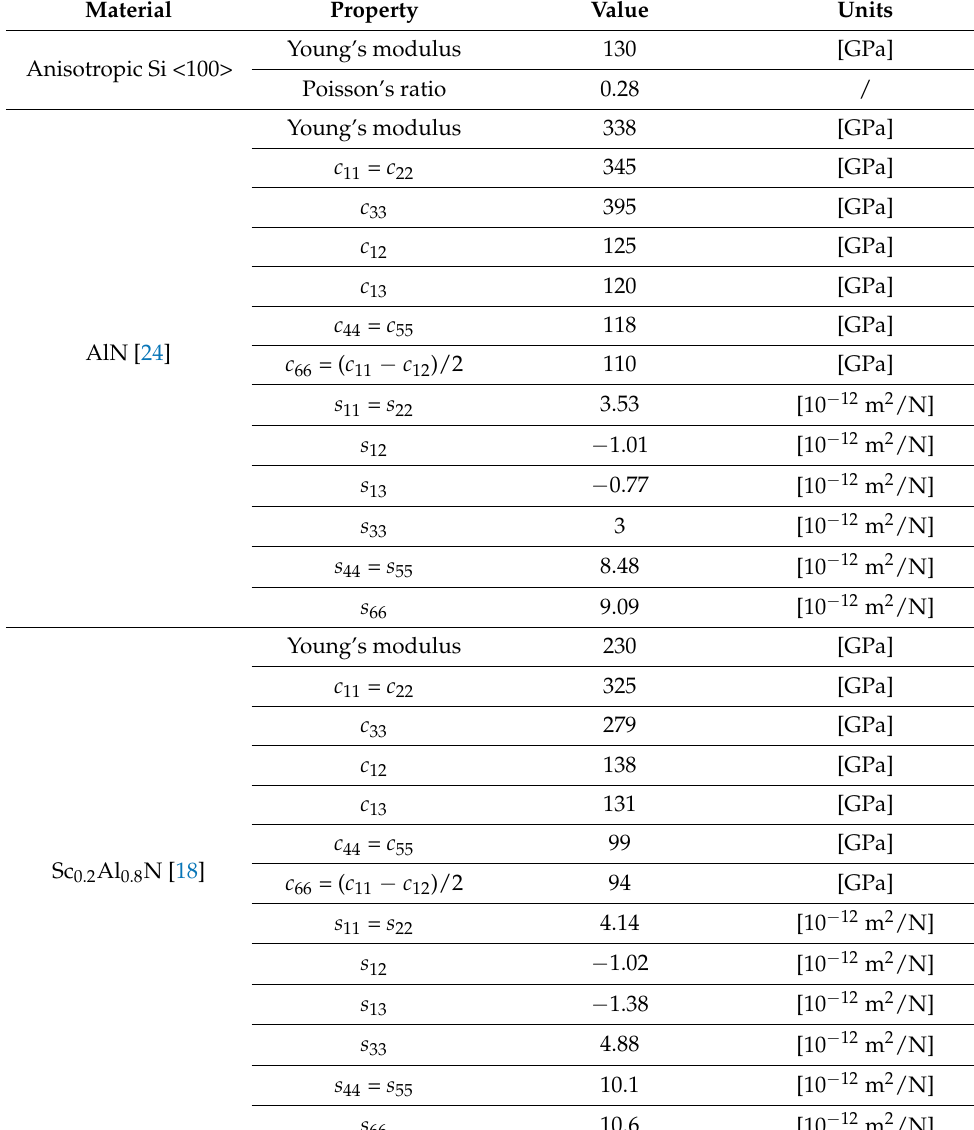
Table 3. The material parameters used in FEM